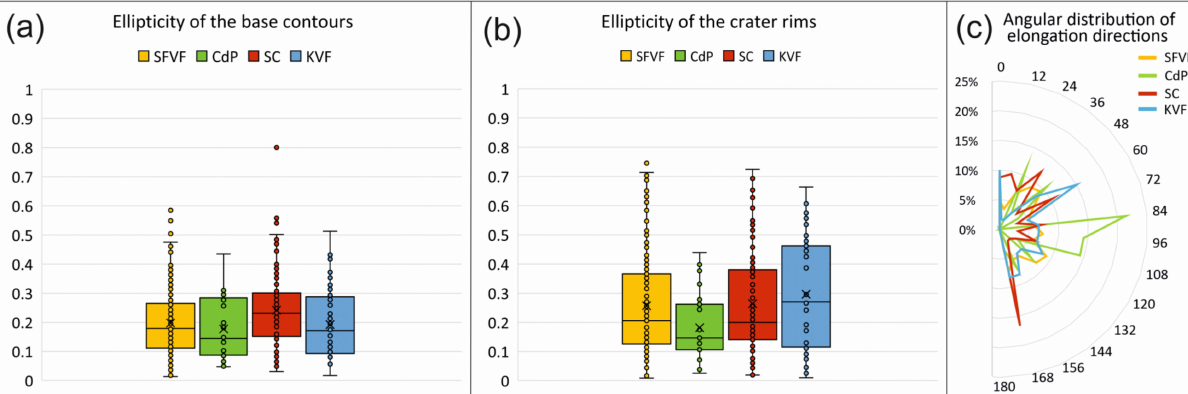
Figure 9. Distance of two differently calculated crater centre coordinates.